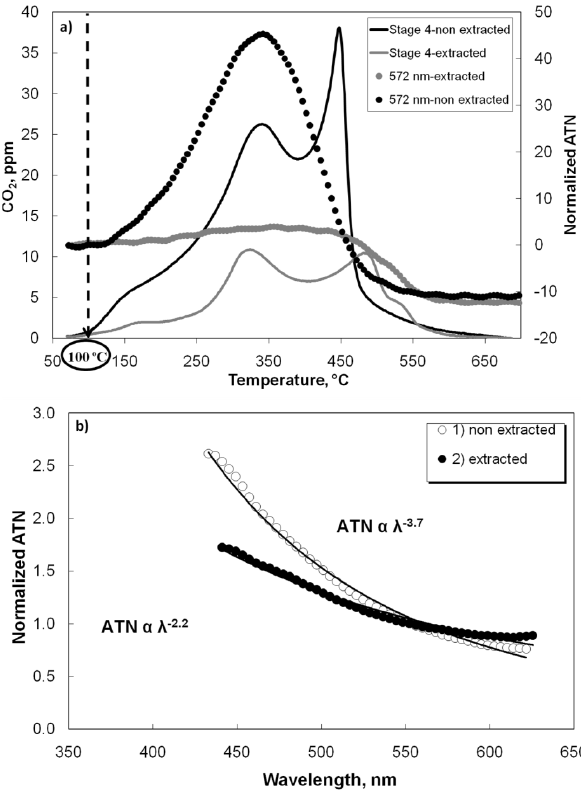
Fig. 3. (a) Thermal-optical analysis of quartz fiber filter samples (water extracted and non-extracted), (b) The spectral attenuation (normalized ATN) measured at 100 ◦ C for DLPI#11-stage 4 ( D p :